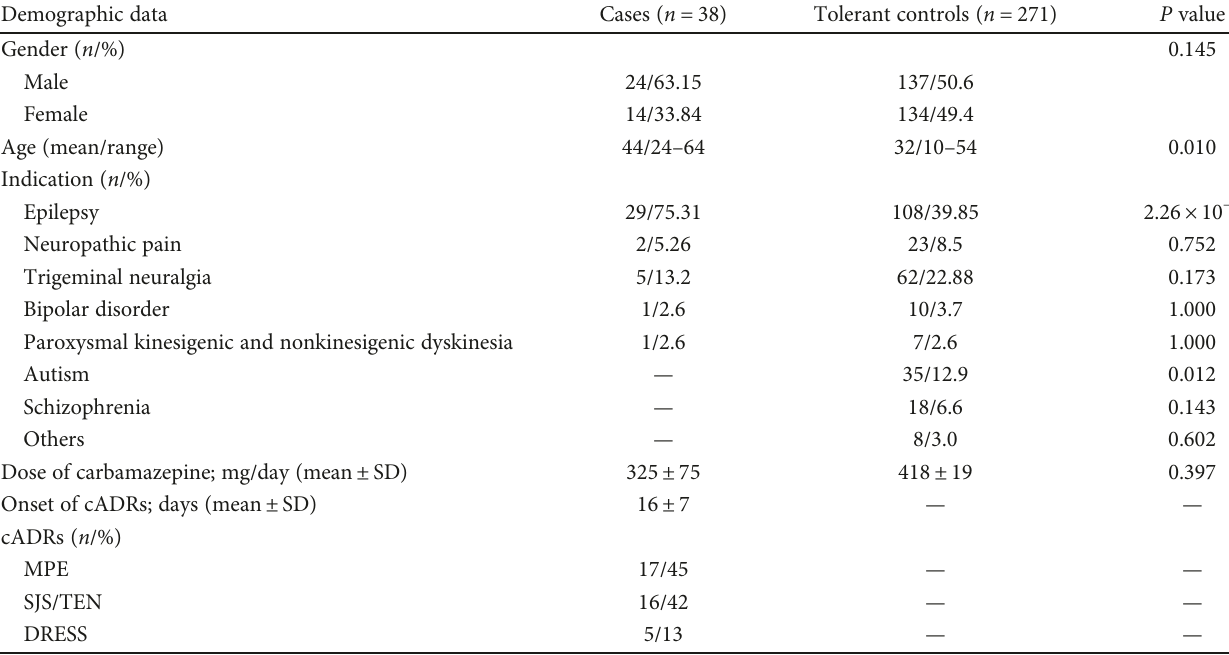
Table 1: Clinical characteristic of patients with carbamazepine-induced cutaneous adverse drug reactions and carbamazepine-tolerant